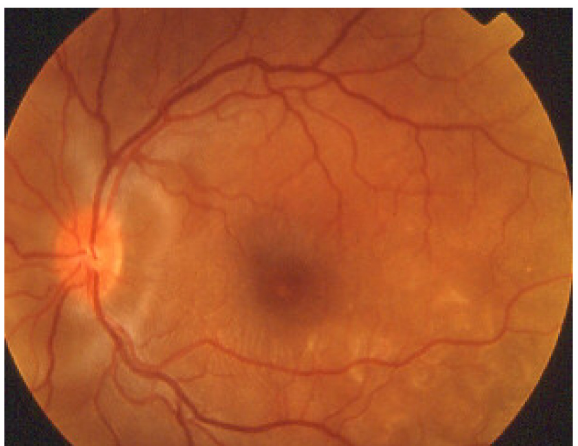
Figure 47. VKH exudative retinal detachments. Fundus photograph showing posterior peripapillary and parafoveal temporal inferior exudative retinal